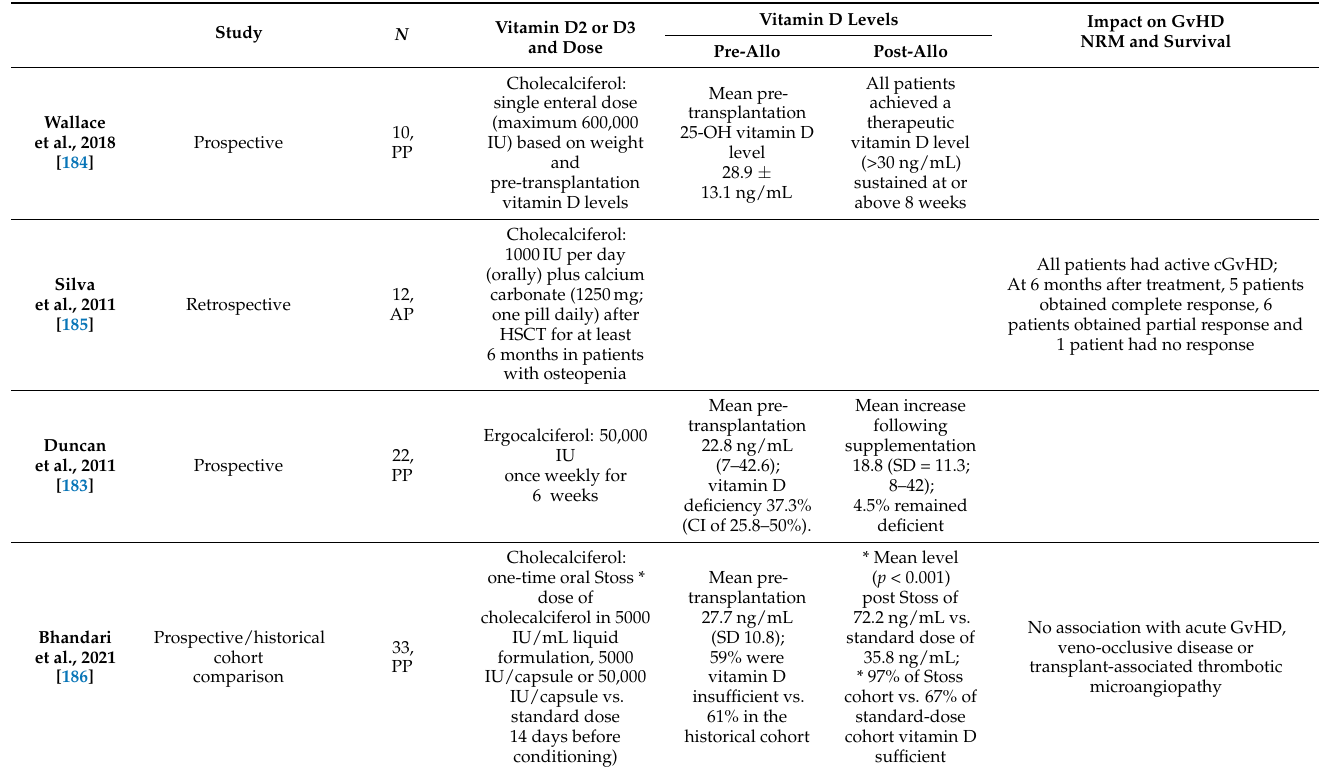
Table 3. Interventional studies evaluating the administration of vitamin D after allogeneic transplan-